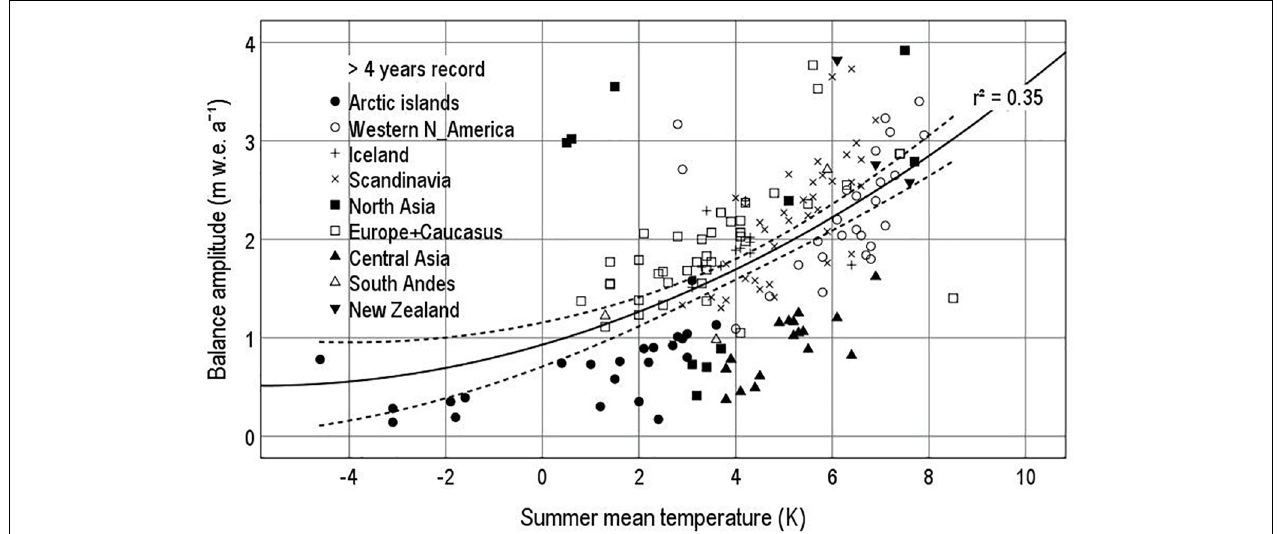
FIGURE 8 | Balance amplitude vs. summer mean temperature from the Climatic Research Unit (CRU)/University of East Anglia (UEA) gridded climatology (New et al., 1999) interpolated to glacier median altitude for glaciers with > 4 years of record in